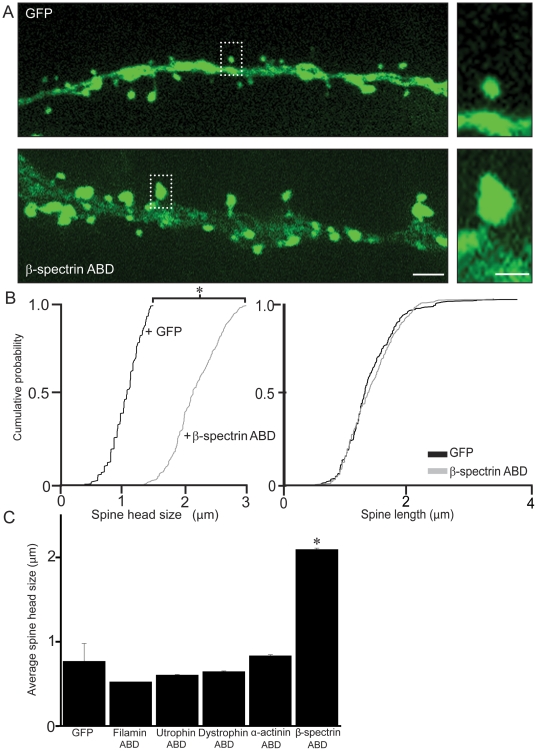
The ABD of βI-spectrin specifically enlarges dendritic spine heads.
A, Images of GFP fluorescence in cells co-transfected with GFP and the ABD of βI-spectrin fused to DsRed, or with GFP alone, illustrate the substantial increase in spine head diameter seen when the ABD of βI-spectrin is overexpressed. Scale = 4 µm (left) and 2 µm (right). B, Cumulative probability plots demonstrate the significant increase in spine head diameter in cells expressing ABD of βI-spectrin when compared to cells transfected with GFP alone, and the lack of a significant effect on spine length (n = 500 spines/5 neurons/group; * = p<0.05, K-S test). C, When compared to the ABD of other spectrin superfamily proteins, only the spines expressing the ABD of βI-spectrin were significantly enlarged (n = 5 neurons/construct; * = p<0.01, ANOVA with Tukey's test).